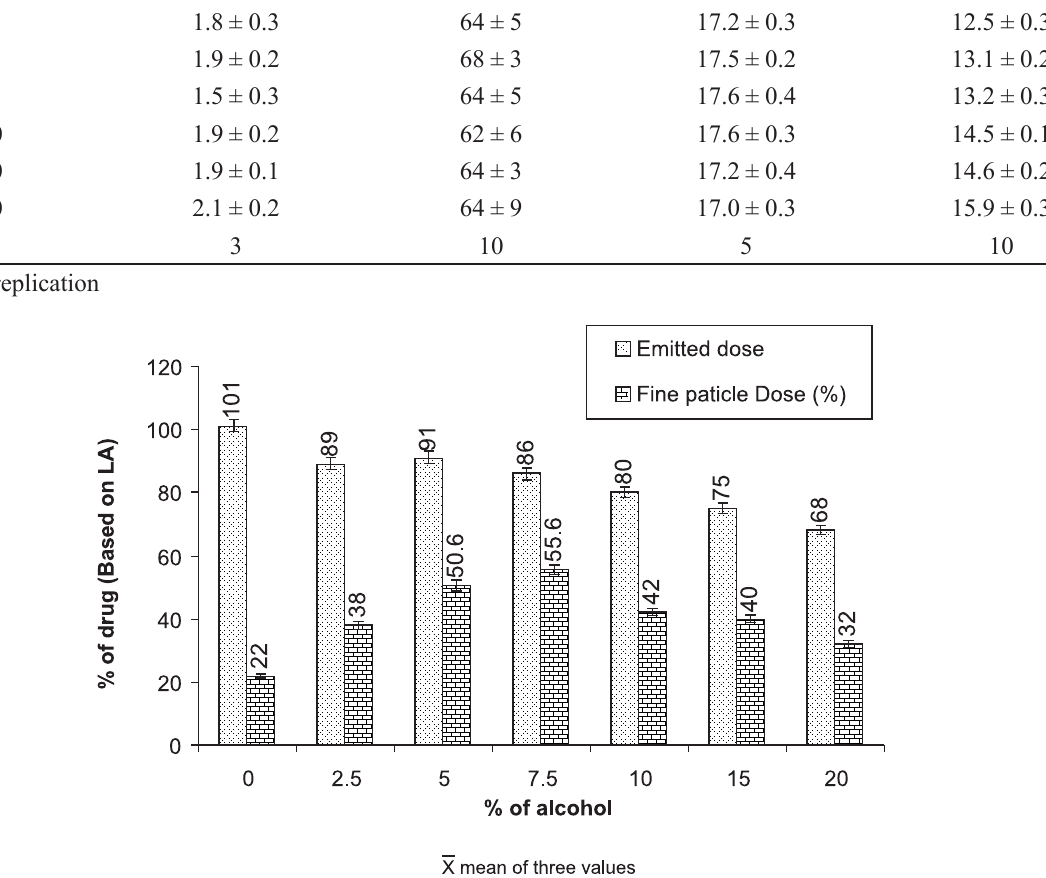
FIGURE 5 - Effect of alcohol content on ED and FP from beclomethasone dipropionate HFA MDI 100 m